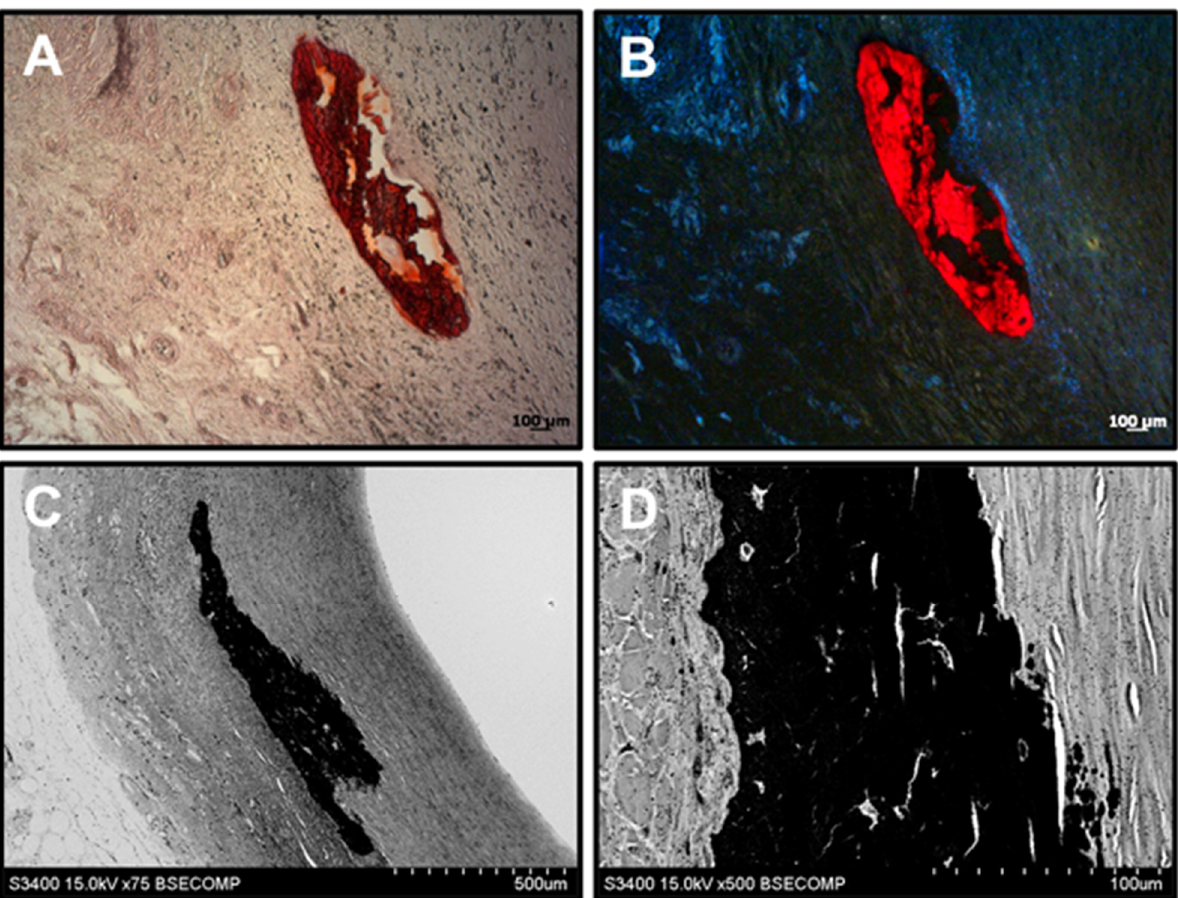
Figure A1. Calcification of a regenerated artery on the border of neointimal and medial layers 18 months postimplantation. ( A ) Alizarin red S staining, light microscopy, ×50 magnification; ( B ) Alizarin red S staining with DAPI counterstaining, ×50 magnification; ( C ) Backscattered scanning electron microscopy, ×75 magnification; ( D ) Backscattered scanning electron microscopy, ×500 magnification.